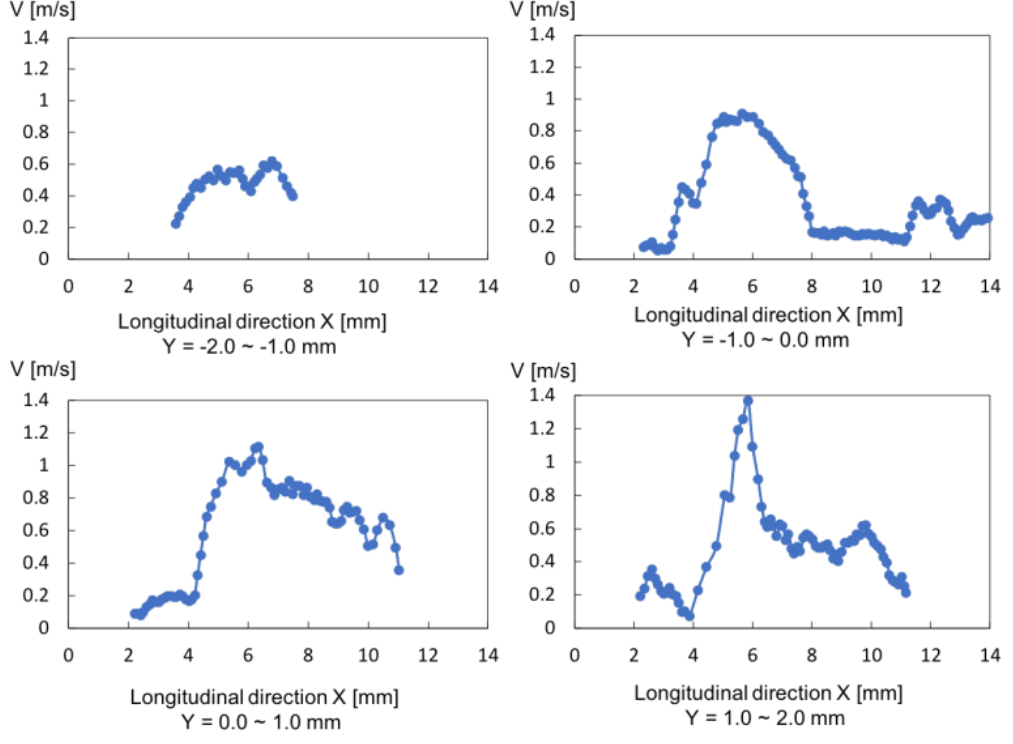
Figure 10. Flow velocity graph in the case of 80 A.